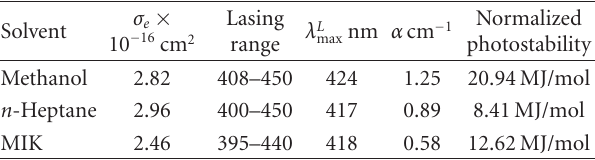
Table 2: Laser parameters of